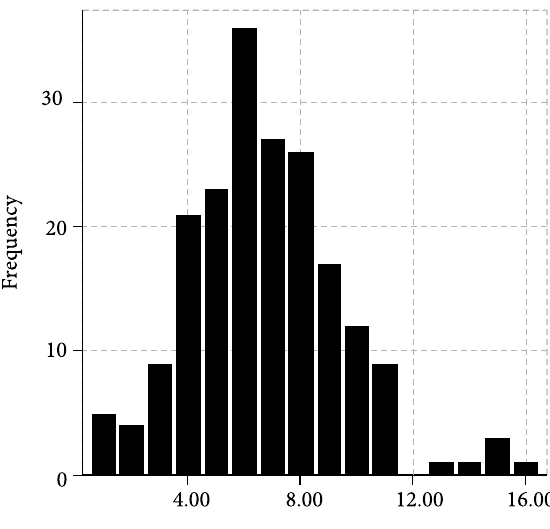
Fig. 1. The frequency distribution of household average trip